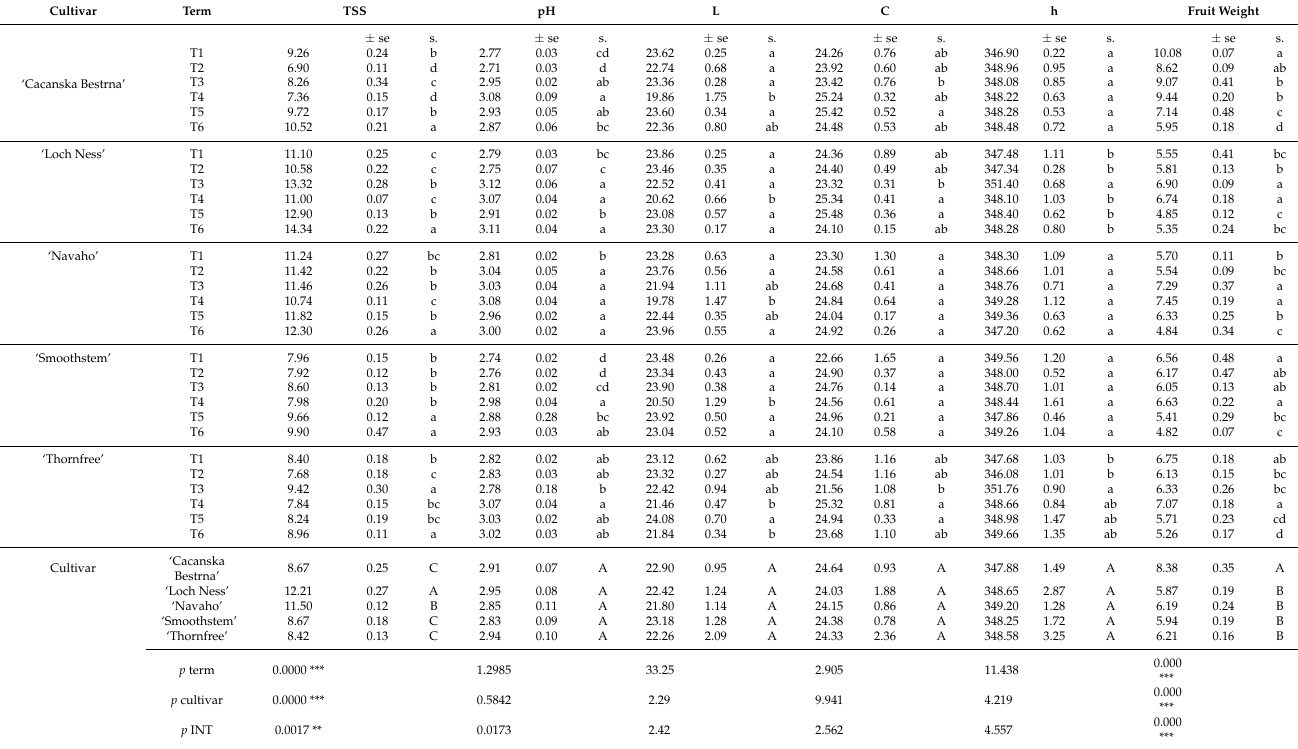
Table 1. The content of different main fruit parameters (mean ± standard error) of blackberry fruits and a two-way ANOVA of the harvest date, cultivar and the interaction between the harvest date × cultivar.